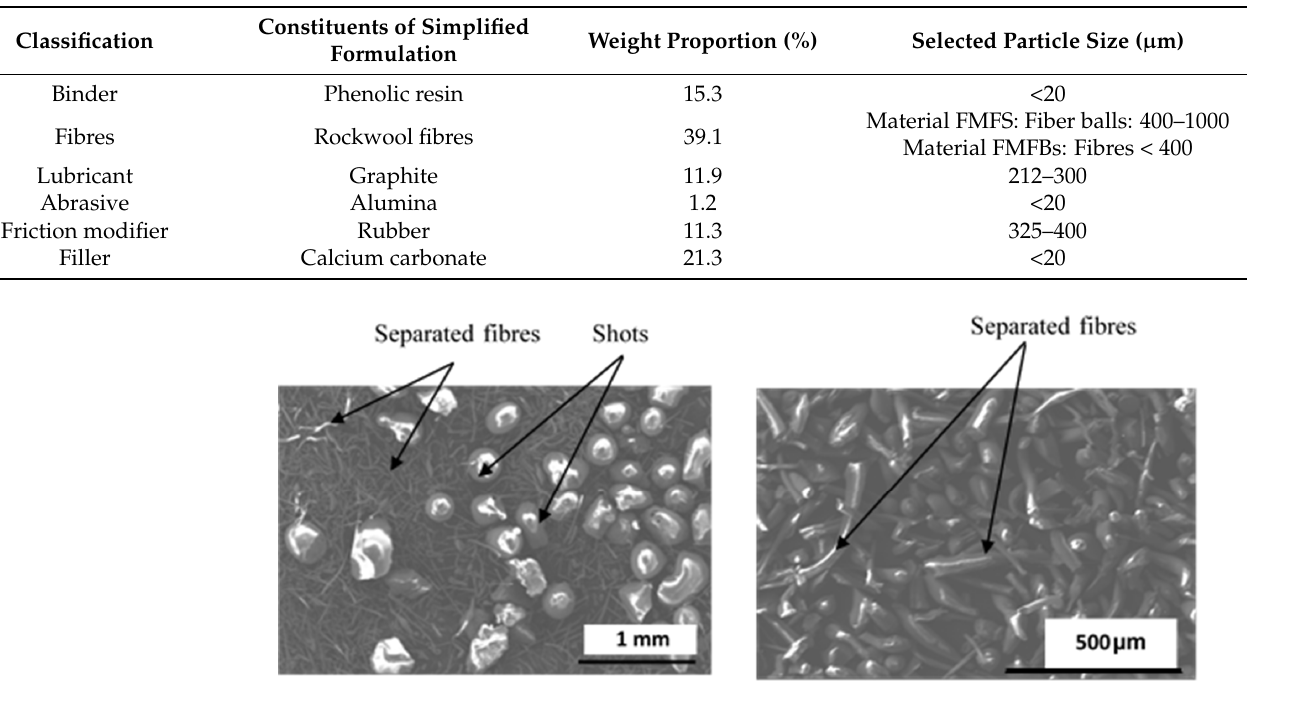
Table 1. Composition and selected particle size of simplified formulations (Friction Material with Fibre Balls (FMFBs) and Friction Material with Separated Fibres (FMFS)).